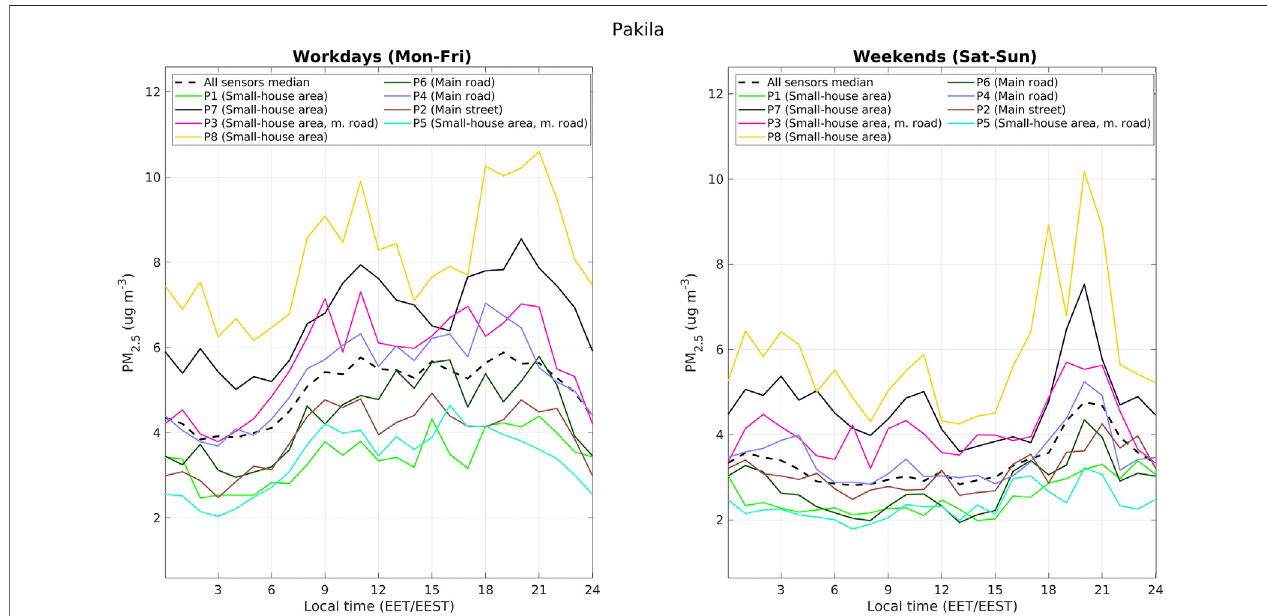
FIGURE 13 | Median diurnal cycles of PM2.5 mass concentrations during 1.1.-28.2.2021 for sensors located in Pakila (left) workdays (Mon-Fri) and (right) weekends (Sat-Sun). Black dashed line shows median diurnal cycle calculated for all data from that